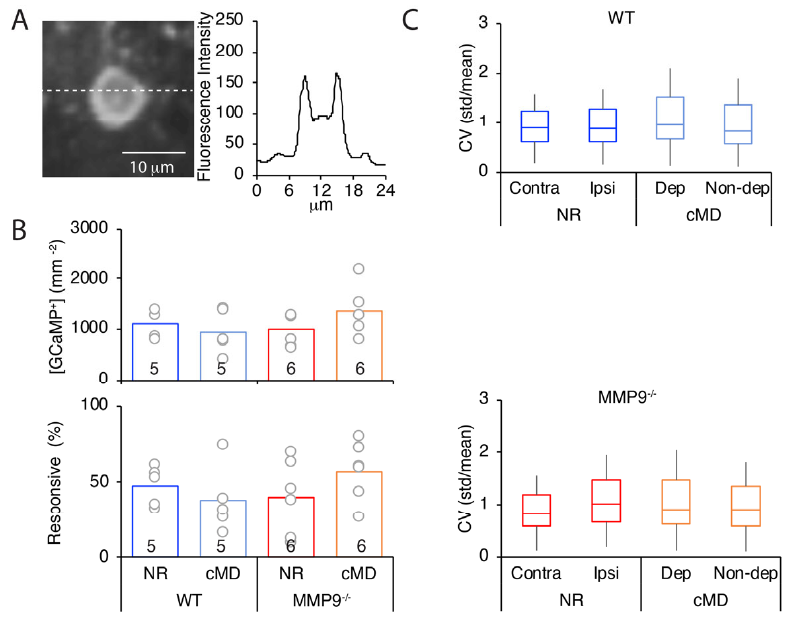
Figure 3. Stability of GCaMP6s expression and visually responsive neurons over experimental conditions. ( A ) Left: representative neuron from layer 2/3 of V1b expressing GCaMP6s. Right: Quantification of fluorescence along dashed white line reveals a high signal in the cytoplasm relative to the nucleus. ( B ) Top: No difference in the total number of GCaMP6s expressing neurons between WT and MMP9 − / − , normal reared (NR) and cMD subjects (one-way ANOVA, F = 3.0, p = 0.06, n = 5 and 6 subjects for WT and MMP9 − / − mice, respectively). Bottom: Percent of GCaMP6s expressing neurons that are visually-responsive (one-way ANOVA, F = 0.96, p = 0.43). A neuron is defined as visually responsive if the mean Δ F value in response to a visual stimulus of any direction exceeds 3 × STD of baseline (F 0 ) for > 40% of trials during either contra or ipsi eye stimulation. ( C ) Coefficient of variance (CV) of calcium transients (standard deviation over mean Δ F/F (STD/mean) is comparable across all experimental conditions, and is unaffected by the deletion of MMP9 or cMD. Box plots represent the median as a bar, 25th to 75th percentile as box, and max and min as whiskers (WT: one-way ANOVA, F = 7.1, p = 0.10, n = 359, 364, 201, and 194 neurons for NR contra, NR ipsi, cMD deprived, and cMD non-deprived, respectively; MMP9 − / − : one-way ANOVA, F = 4.3, p = 0.11, n = 315, 321, 595, and 595 neurons for NR contra, NR ipsi, cMD deprived, and cMD non-deprived,